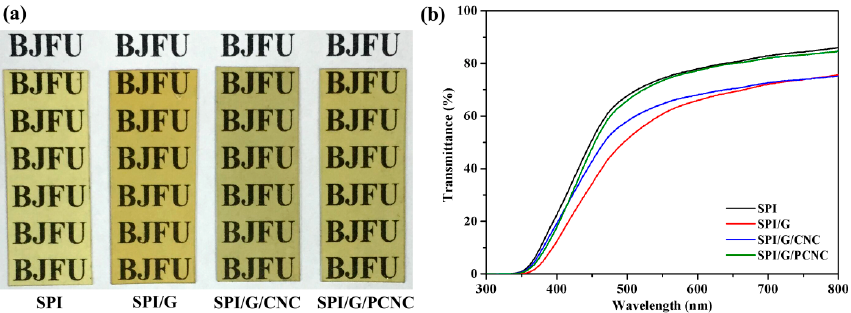
Figure 5. (a) Appearance photographs and (b) UV–Vis transmittance spectra of SPI film and Figure 5. ( a ) Appearance photographs and ( b ) UV–Vis transmittance spectra of SPI film and SPI-based SPI-based films modified with graphene, CNC, and PCNC. films modified with graphene, CNC, and PCNC.